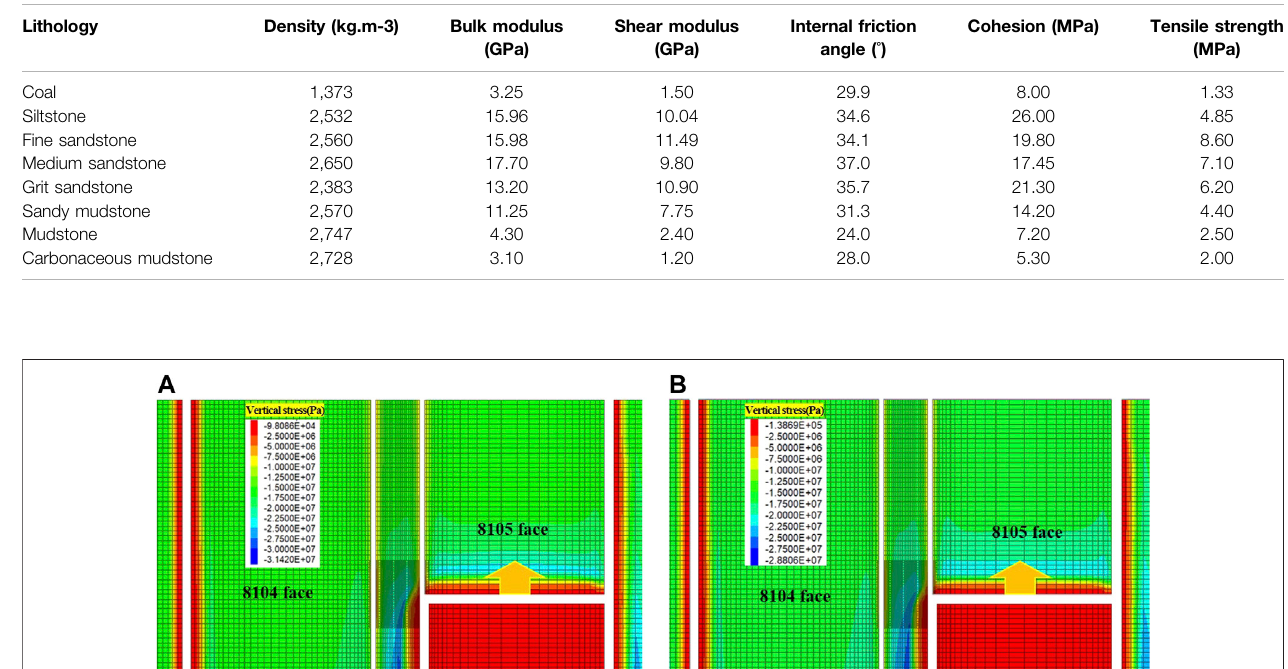
TABLE 4 | Mechanical parameters of rock mass in each layer of the model.